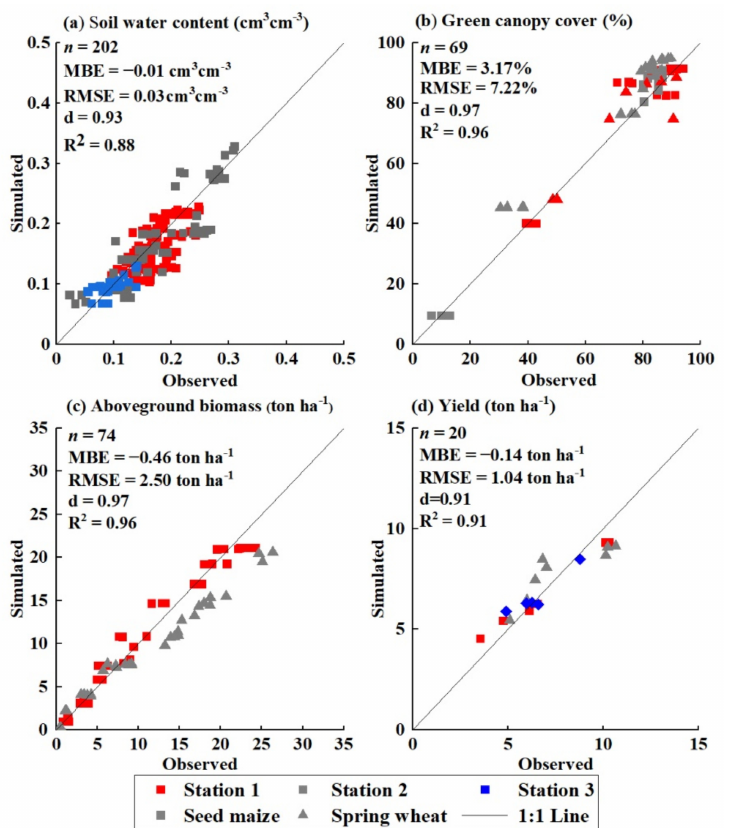
Figure 3. Comparisons between the observed and simulated ( a ) soil water content, ( b ) crop canopy cover, ( c ) aboveground biomass, and ( d ) yield at the three experimental stations during the calibration period. Table 4. Statistical indicators of annual crop yield simulation.